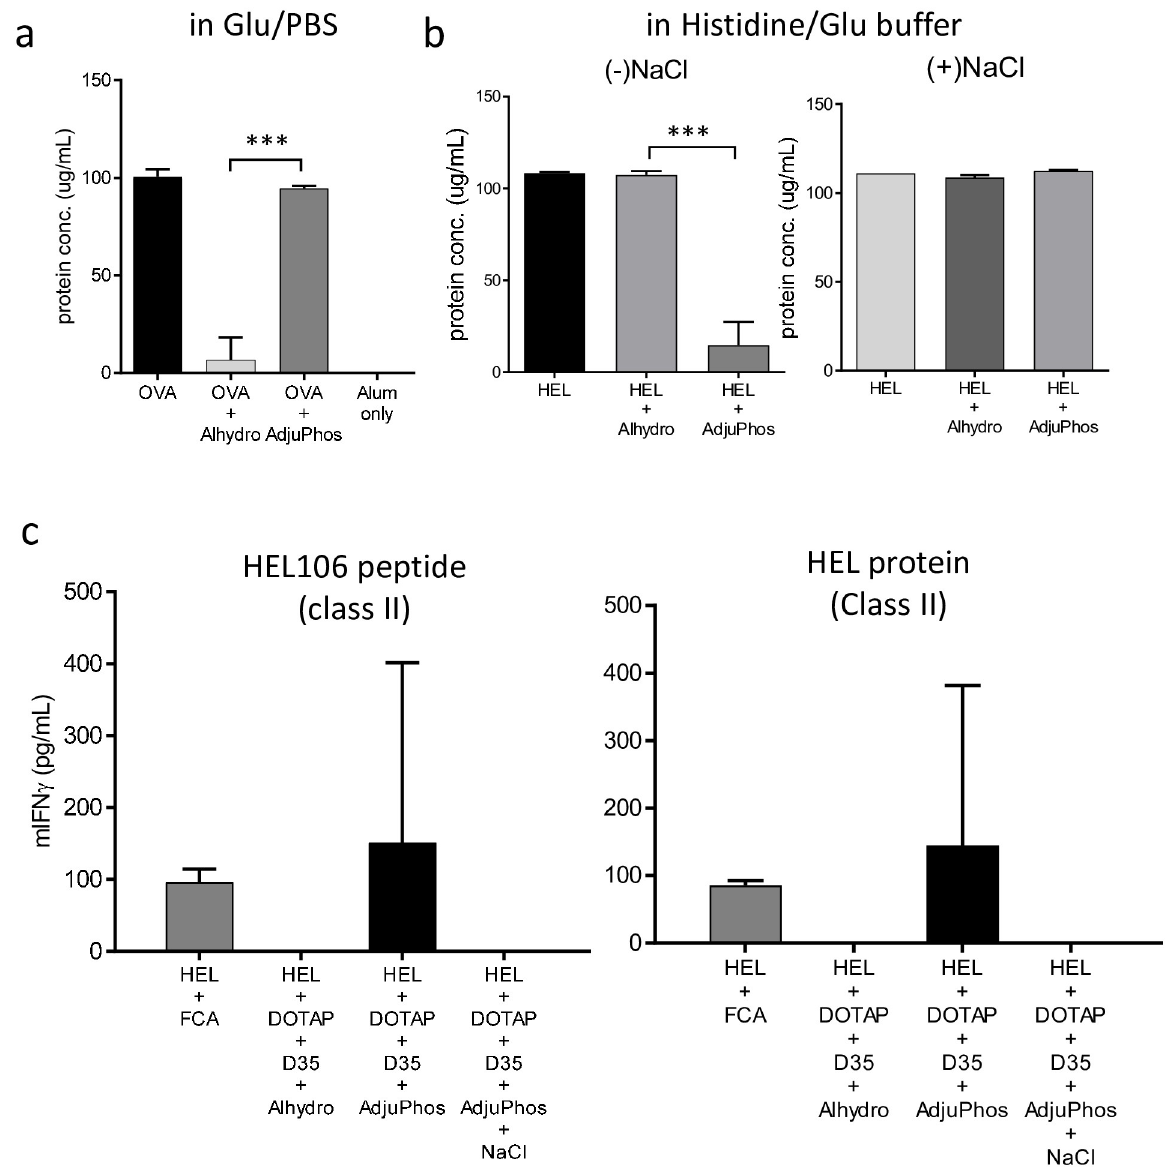
Fig 3. The interaction of the antigen and aluminum salt is important for the induction of T cell response with the combination adjuvant. OVA (10 μ g), OVA plus Alhydrogel (40 μ g), and OVA plus AdjuPhos (40 μ g) in Glu/PBS were mixed and centrifuged at 5000 rpm for 3 min. The protein concentration in the supernatant was measured using a Qubit Protein Assay Kit. HEL (10 μ g) only, HEL plus Alhydrogel (40 μ g), HEL plus AdjuPhos (40 μ g) in 20 mM histidine buffer (pH 6.5)(Glu/His buffer) (a) or in 20 mM histidine with 150 mM NaCl buffer (pH 6.5)(Glu/His +NaCl buffer) (b) were assayed in a similar manner. The bar graph indicates the mean ± SD of triplicate experiments. Statistical significance is indicated by an asterisk in the bar graph; ��� p < 0.001(parametric unpaired t-test). (c) BALB/c mice were immunized with the indicated combination adjuvant. HEL (10 μ g), DOTAP (100 μ g), D35 (10 μ g), and Alhydrogel or AdjuPhos (40 μ g) in a 1:1 mixture of 5% glucose and histidine buffer (Glu/His) were used. As a control, HEL (10 μ g) was also immunized with the FCA emulsion (see Methods). The AdjuPhos group also used as another control with 0.15 M NaCl addition. Seven days after immunization, splenocytes were collected and stimulated with HEL107- 116 peptide or HEL protein to induce CD4 + T cell response. After 24 h, the concentration of mouse IFN- γ in the culture supernatant was measured by ELISA. The bar graph indicates the mean + SD of cytokine concentrations derived from three mice per group. The data are representative of at least two independent experiments with similar results.